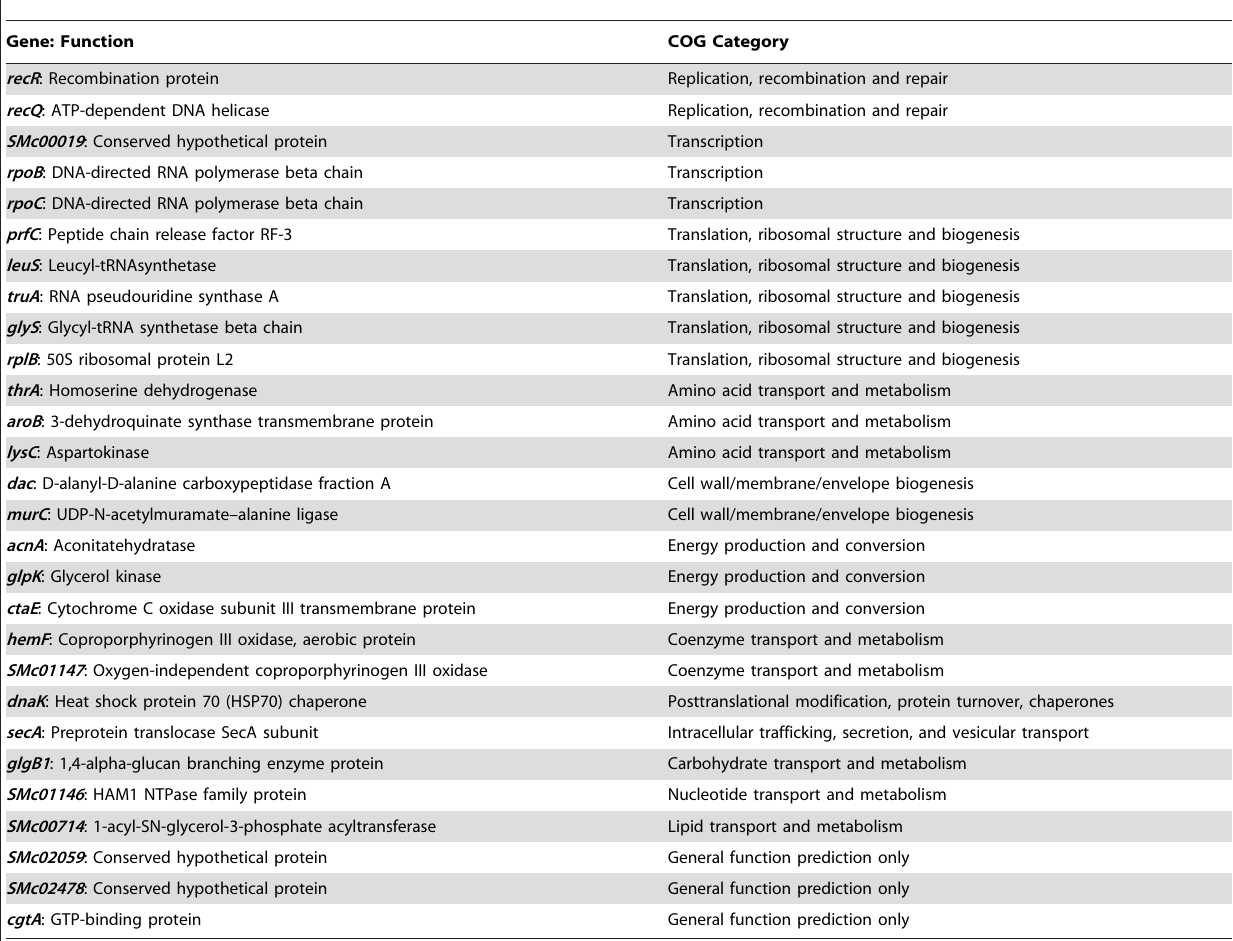
Table 1. 28 core genes of rhizobia used in this